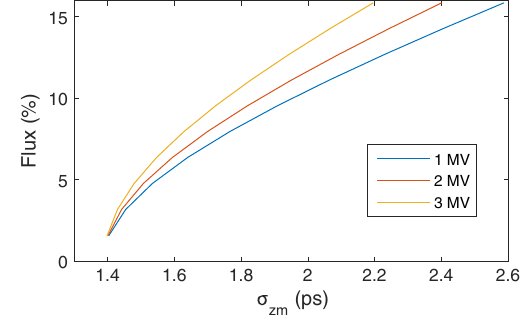
FIG. 4. Percentage of flux vs pulse duration for various deflecting voltages.